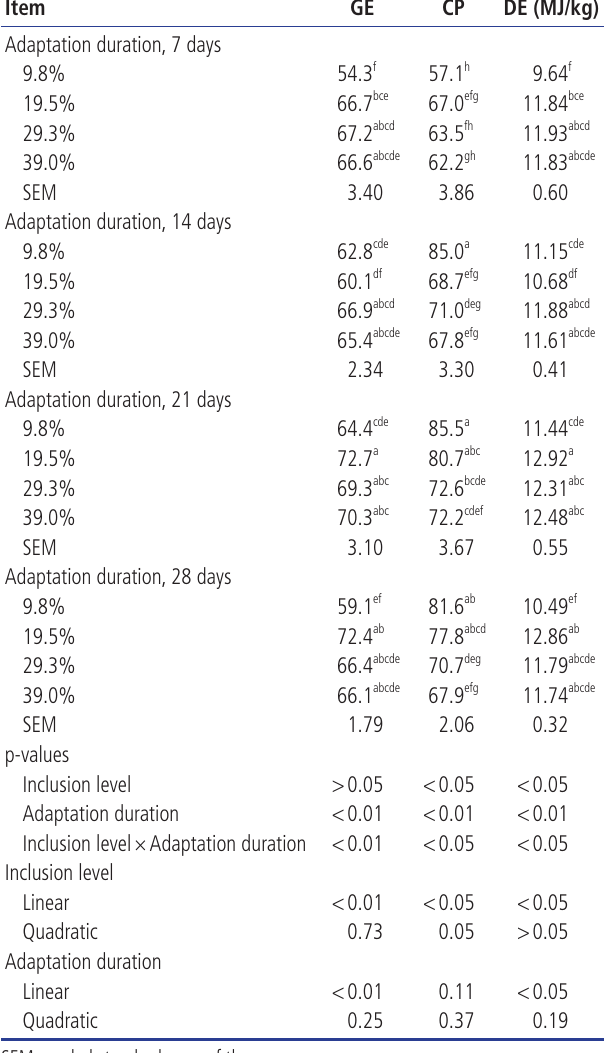
Table 6. Effects of inclusion levels of palm kernel meal (%) and adaptation duration (days) on its concentration of digestible energy (DE, as fed-basis) and the apparent total tract digestibility (ATTD, %) of gross energy (GE) and crude protein (CP) fed to growing pigs 1),